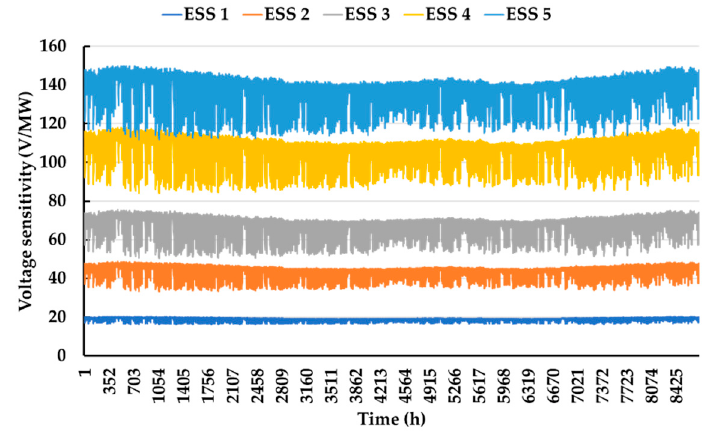
Figure 10. Voltage sensitivity based on the proposed method.